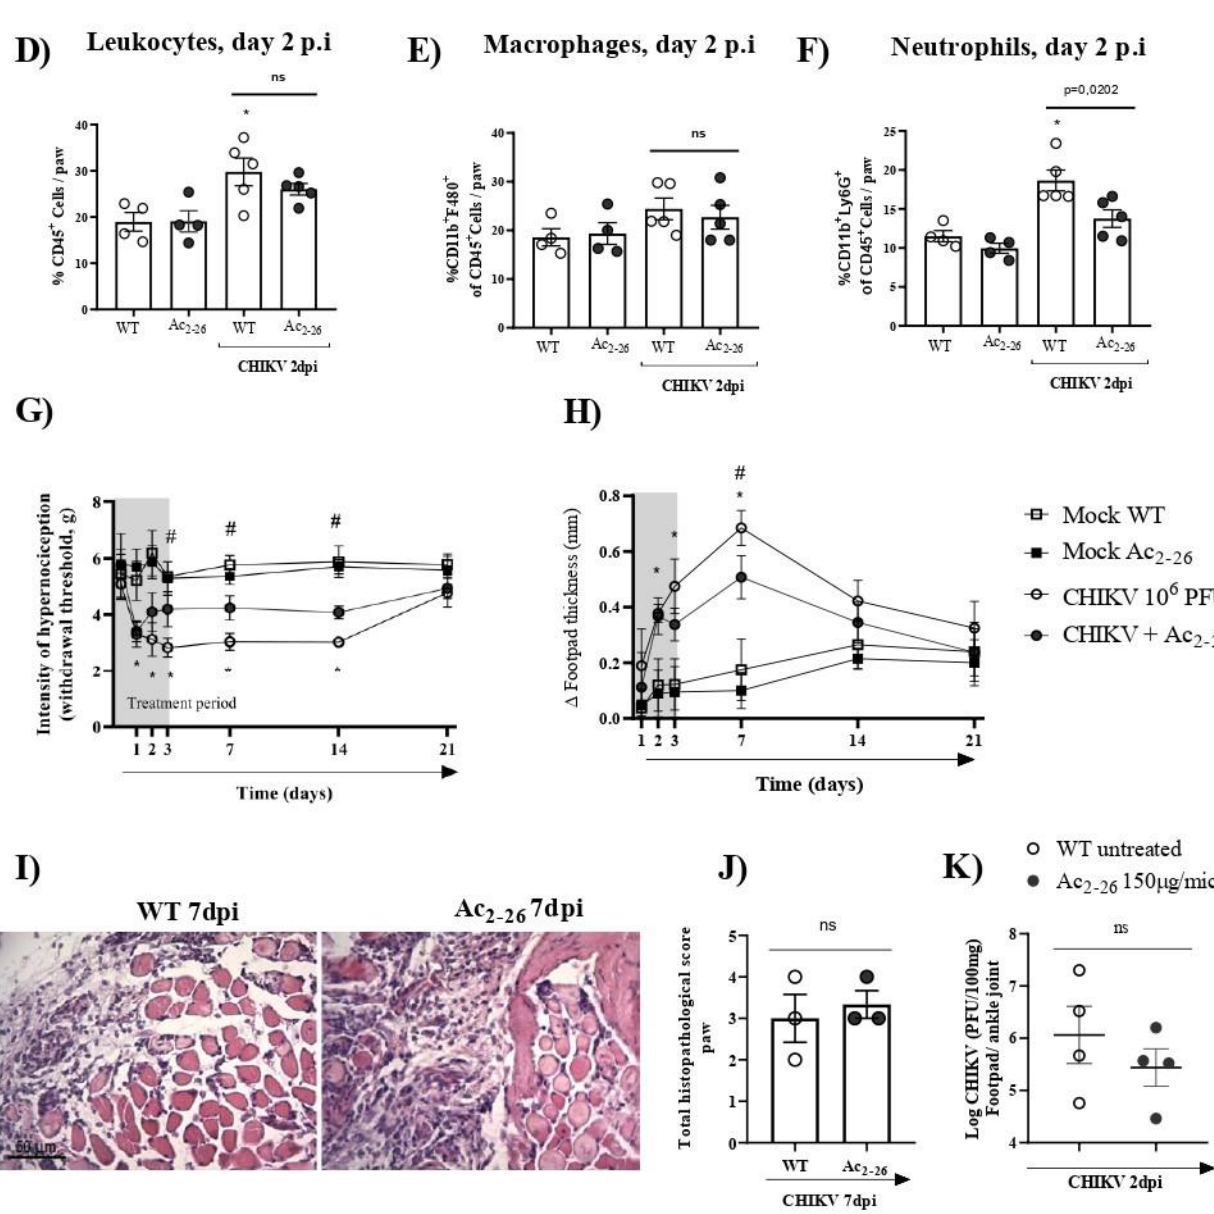
Figure 6. Effects of Ac 2–26 treatment in inflammatory responses and hypernociception induced by CHIKV-infection. BALB/c mice received Ac 2–26 (150 µ g/mice, intraperitoneal route), and 1 h